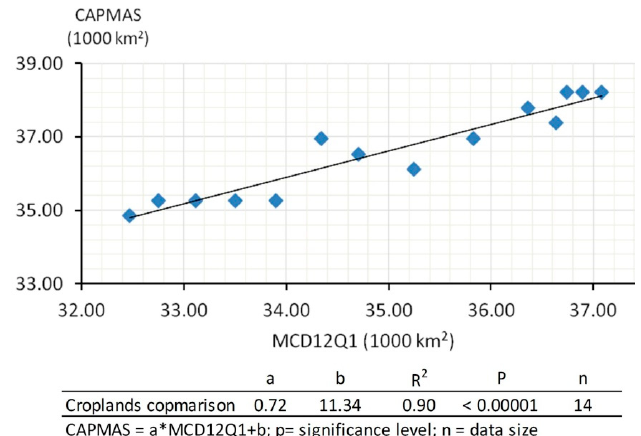
Figure 3. Correlation between the agricultural areas estimated by the MCD12Q1 land cover and official Egyptian statistics by the CAPMAS (2004–2017) .